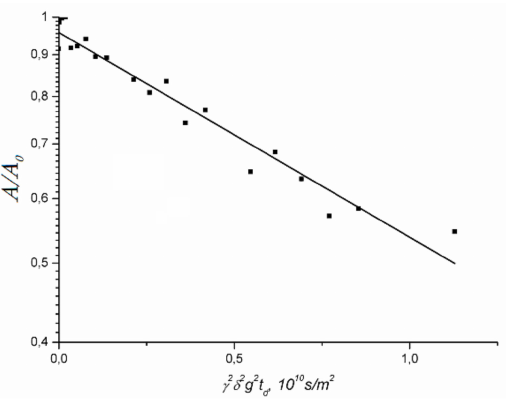
Figure 38. Diffusion decay of 133 Cs nuclei in Nafion membrane Cs + ionic form, RH = 95%, t = 20 ◦ C. Reprinted with permission from [109]. Copyright 2021